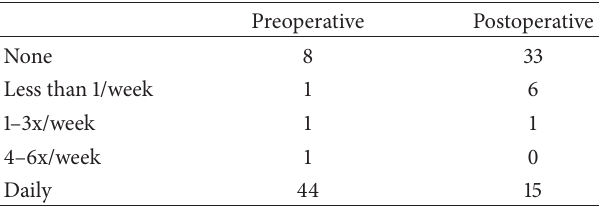
Table 1: Comparison of preoperative and postoperative PPI